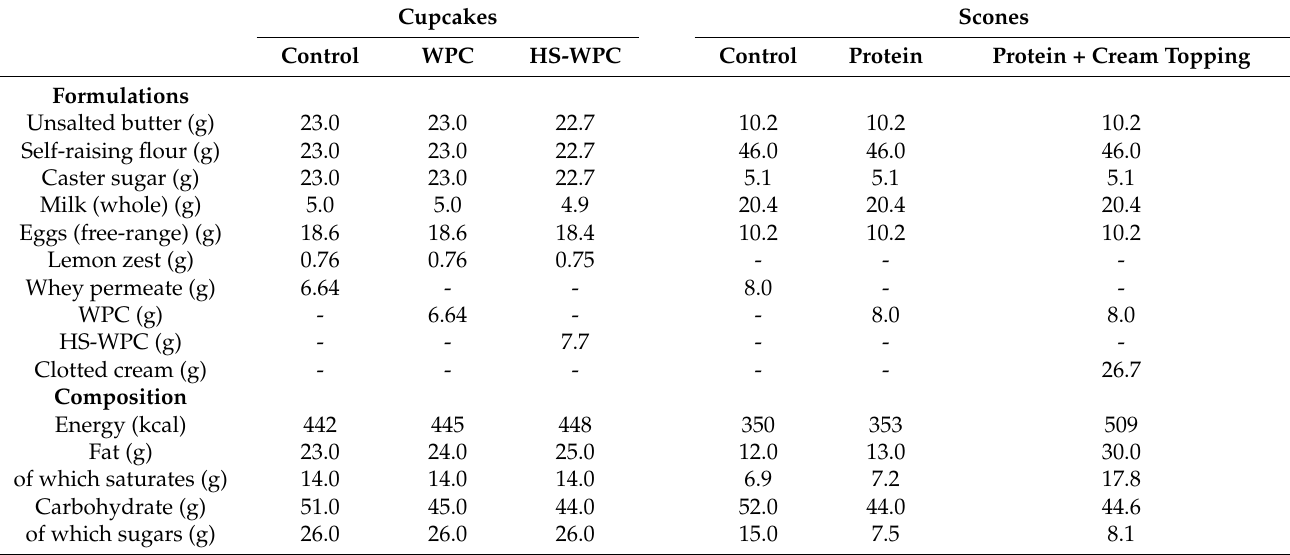
Table 2. Overview of whey protein solid model cupcakes and scones (WPC: whey protein concentrate; HS-WPC: heat stable whey protein concentrate) per 100